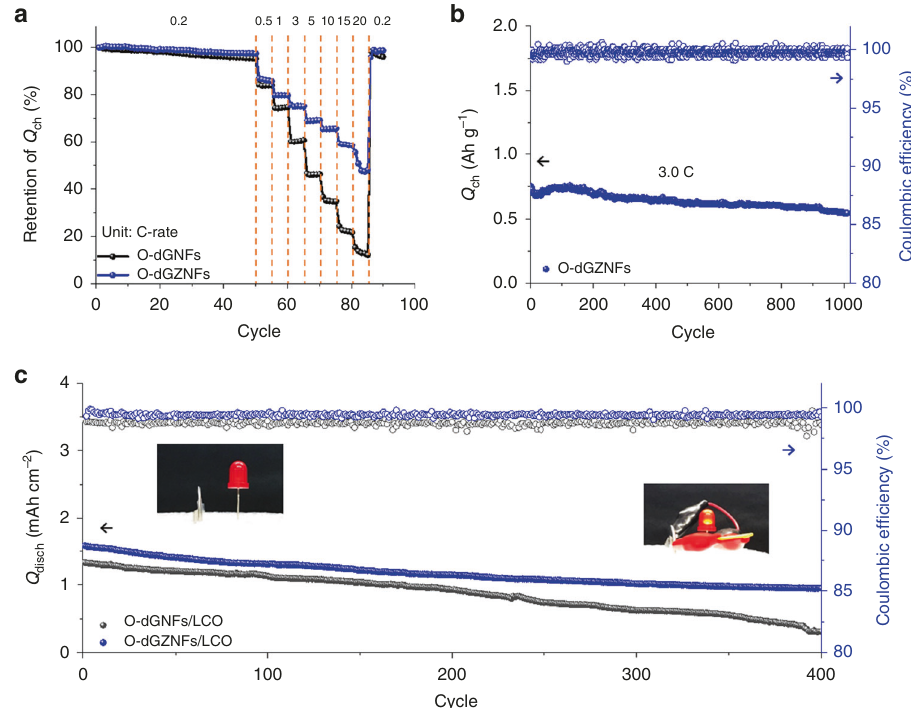
Fig. 6 Rate capability and long-term cyclic stability in both half and full cells. a Rate capability of O-dGNFs and O-dGZNFs. b Cyclic performance of O- dGZNFs at 3.0 C-rate. c Electrochemical performance of full cells assembled with LCO at 1.0 C-rate. Inset photographs indicate the charged O-dGZNFs/LCO full cell before and after closing the